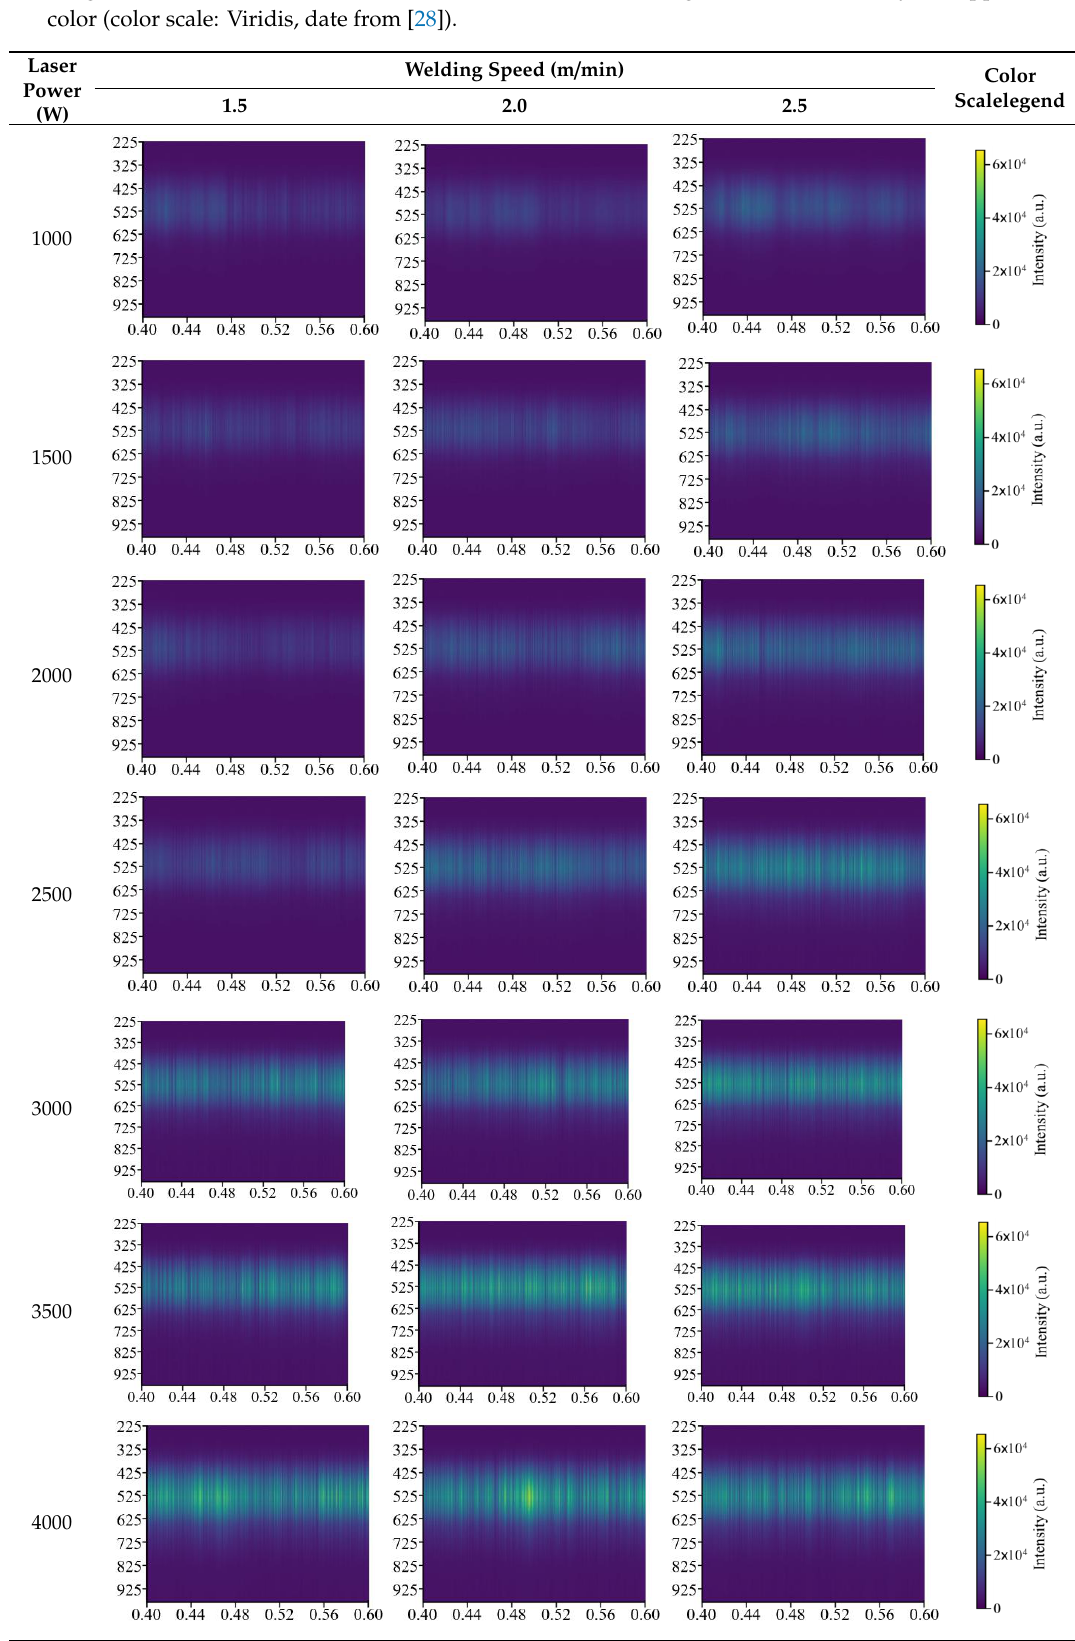
Table 4. Color-coded images of spectrum at a gap of 0.8 mm according to the laser power and welding speed: in each image, the horizontal axis is time (s), the vertical axis is wavelength (nm), and intensity is mapped in color (color scale: Viridis, data from [28]).